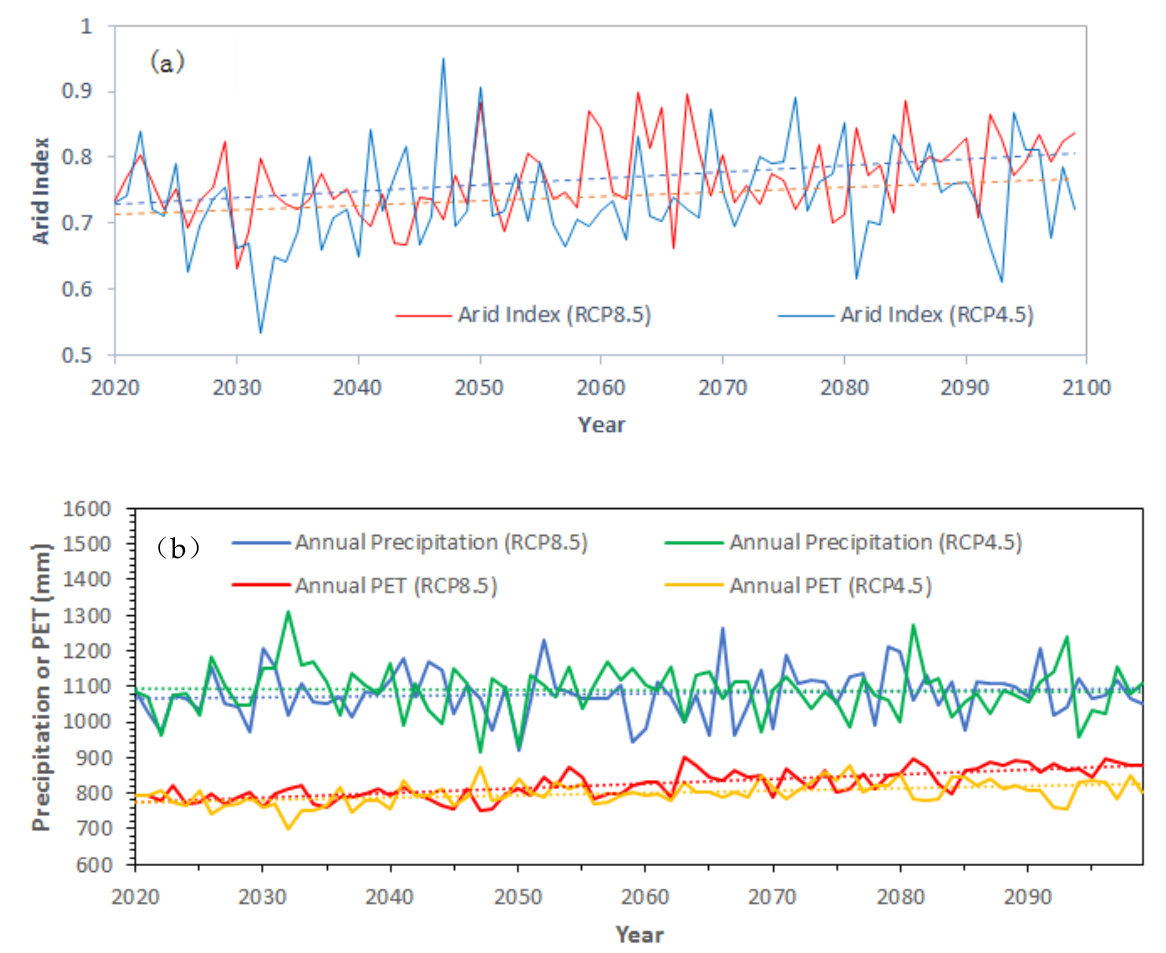
Figure 6. The annual averaged aridity index under RCP4.5 (( a ), blue line) and RCP8.5 (( a ), red line); the annual precipitation under RCP4.5 (( b ), green line) and RCP8.5 (( b ), blue line); annual PET under RCP4.5 (( b ), yellow line) and RCP8.5 (( b ), red line) in China from 2021 to 2099. The dashed line shows a linear trend.